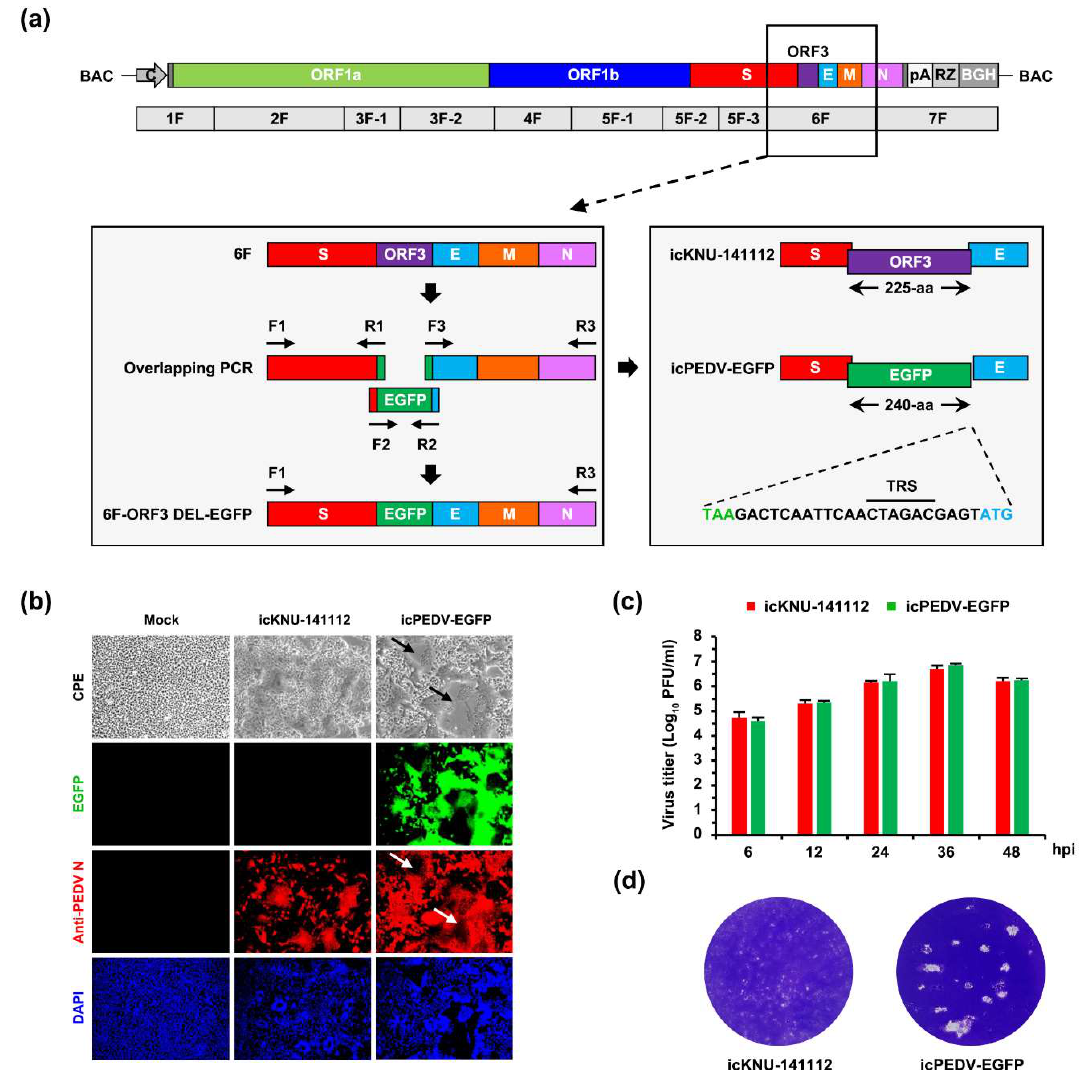
Figure 4. Construction and virological properties of recombinant icPEDV-EGFP. ( a ) Strategy for constructing the recombinant molecular clone KNU-141112-EGFP in BAC. The illustration on top represents the genome organization of KNU-141112, with different colored boxes symbolizing viral genes. The second diagram represents seven overlapping cDNA fragments (1F to 7F) comprising the KNU-141112 genome. Acronyms for viral genes and regulatory elements are described in Figure 1. The diagram on the left panel represents an enlarged version of fragment 6F, with different col- ored boxes indicating partial S (red), ORF3 (purple), E (cyan), M (orange), and partial N (pink). Three amplicons encompassing 6F, including EFGP (green) flanked by PEDV sequences, are illus- trated with different colored boxes, which were individually PCR amplified using respective primer sets (hypothetically named F1-R1, F2-R2, and F3-R3), indicated by arrows and then used as tem- plates for overlapping PCR using an “F1-R3” primer set to generate the 6F-ORF3 DEL-EGFP frag- ment depicted at the bottom. The modified fragment 6F was cloned into the plasmid pBAC-CMV- KNU-141112 to produce the recombinant infectious clone pBAC-CMV-KNU-141112-EGFP. In the right panel, the parental 225-aa ORF3 gene flanked by S and E sequences is depicted at the top. The second illustration represents the recombinant 240-aa EGFP flanked by S and E sequences. The 3′- terminal 22-nt sequence of ORF3, including the TRS of E, flanked by the stop codon in EGFP and the start codon in E, which were not removed to maintain E expression, is shown at the bottom. ( b ) Phenotypic characteristics of icPEDV-EGFP. Vero cells were mock infected or infected with icKNU- 141112 and icPEDV-EGFP at an MOI of 0.1. PEDV-specific CPE was observed daily, and cells were photographed at 24 hpi using an inverted microscope at a magnification of 200× (top panels). For immunostaining, infected cells were fixed at 24 hpi and incubated with MAb against N protein,